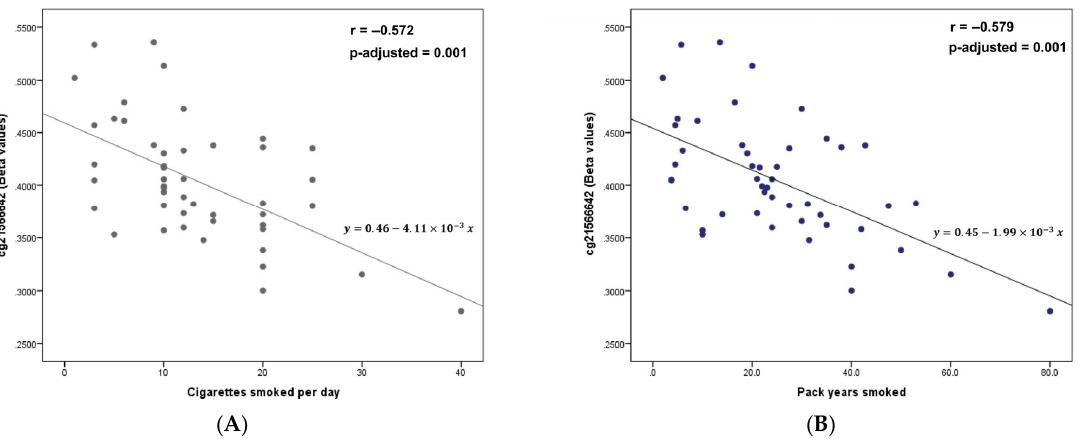
Figure 6. Scatter plot for the association between methylation levels in the cg1566642 site (beta-values) and cigarettes smoked per day (panel A ), and pack-years smoked (panel B ) in current smokers (n = 48).